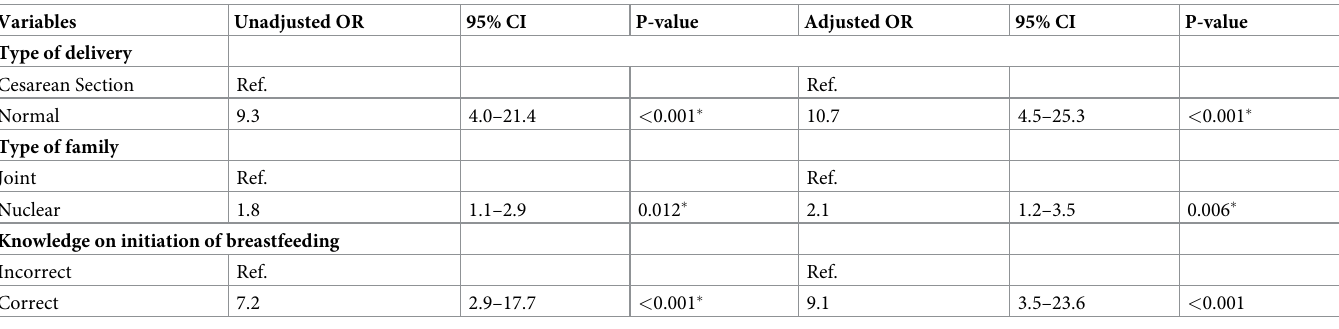
Table 4. Factors associated with timely initiation of